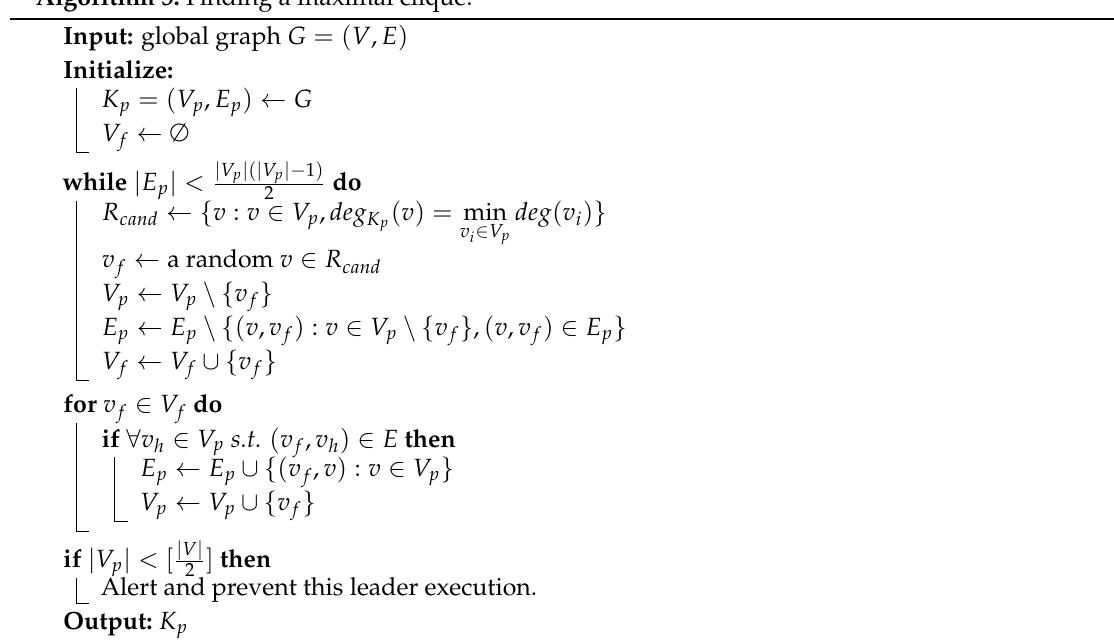
Algorithm 5: Finding a maximal